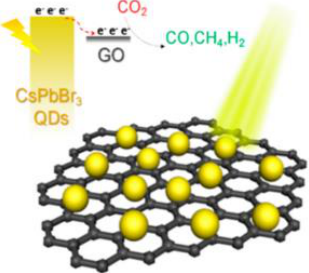
Figure 5. Schematic of photocatalytic CO 2 reduction over CsPbBr 3 QDs/GO. Reprinted with permission from Ref. [77]. 2017 Xu, Y.-F.; Yang, M.-Z.; Chen, B.-X.; Wang, X.-D.; Chen, H.-Y.; Kuang, D.-B.; Su, C.-Y.